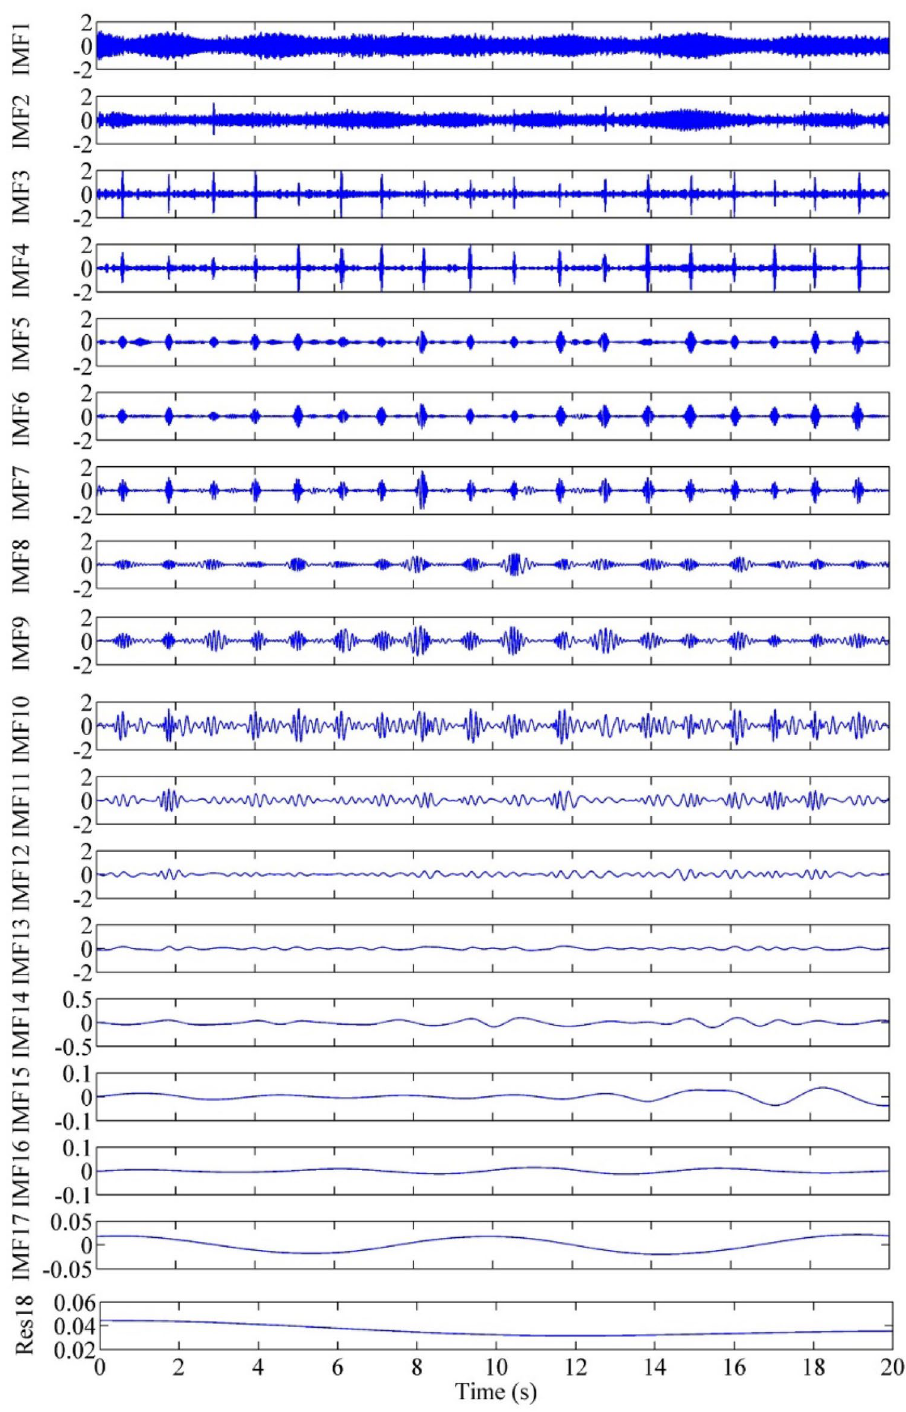
Figure 5. EMD decomposition IMFs of